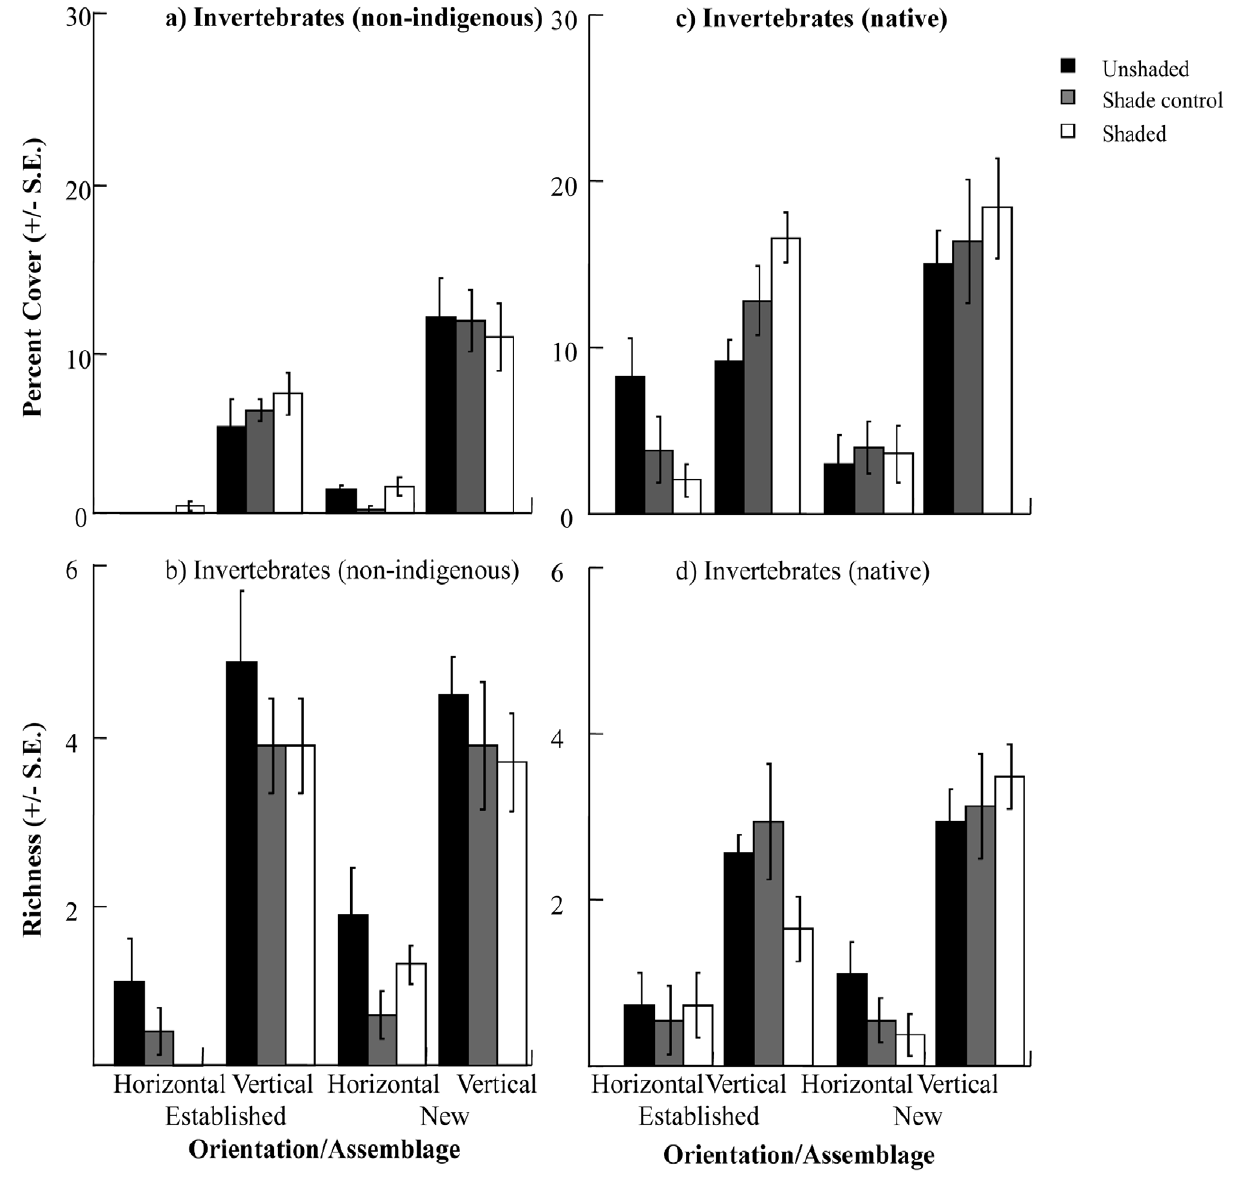
Figure 6. Percent covers and richness of invertebrates sampled on experimental ‘‘reef’’. (a, b) non-indigenous invertebrates and (c, d ) native invertebrates were sampled on experimentally deployed sandstone plates. Bars are separated by orientation (horizontal or vertical) and assemblage (new or established) and coded for shading treatment (unshaded, shade control or shaded).